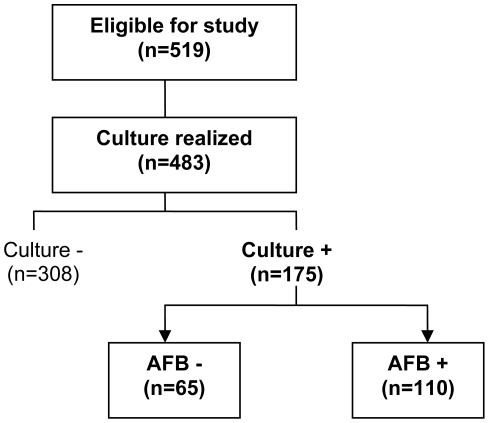
Distribution of AFB-positive and AFB-negative patients with definite tuberculosis in Cambodia and Africa.